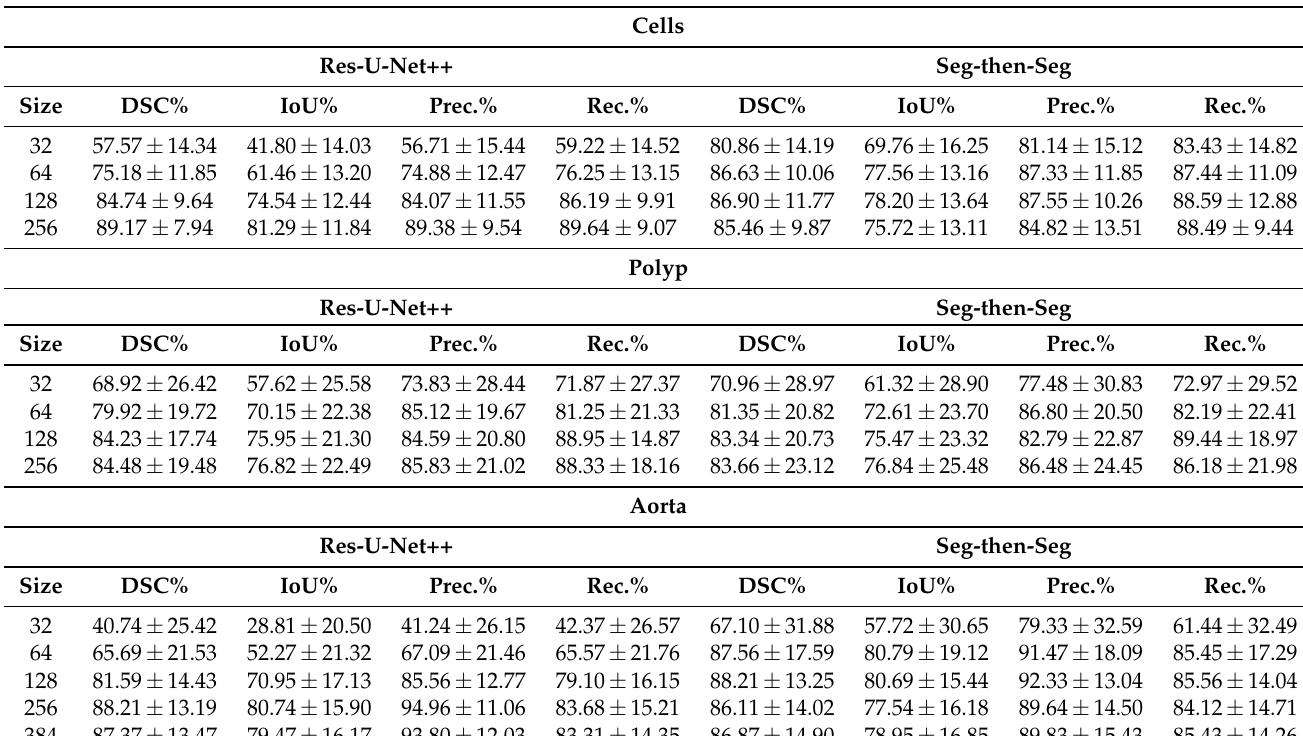
Table A2. The full results of each of our Res-U-Net++